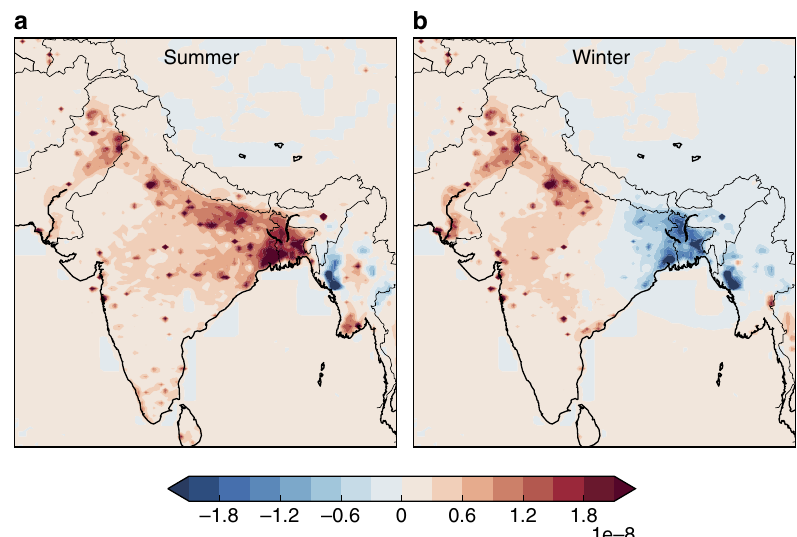
Fig. 2 Differences in emissions between seasons. a Difference between the average summer (June – Sept) or b average winter (Jan – Feb) peak emission periods, and the average of spring/autumn minimum emission periods (March – May, October – December) in g m − 2 s − 1 . Scaling factors to the prior fl ux map for each month were estimated for ~40 spatial basis functions within this domain; the prior map was scaled up or down by this factor for each basis